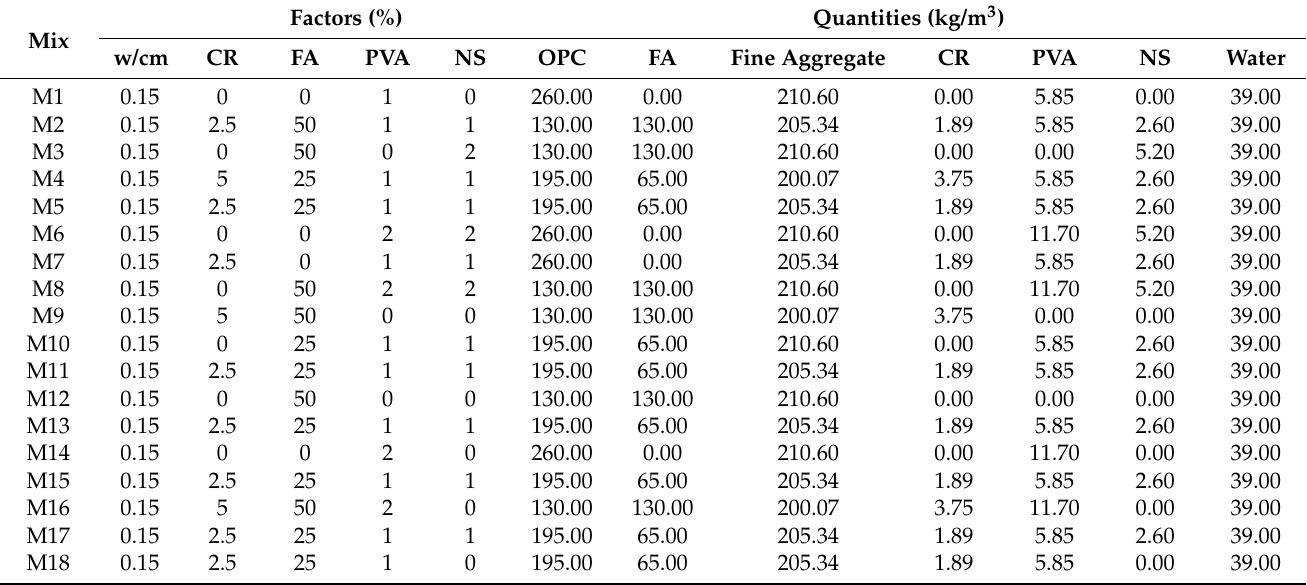
Table 4. Mixture constituents of each rubberized ECC